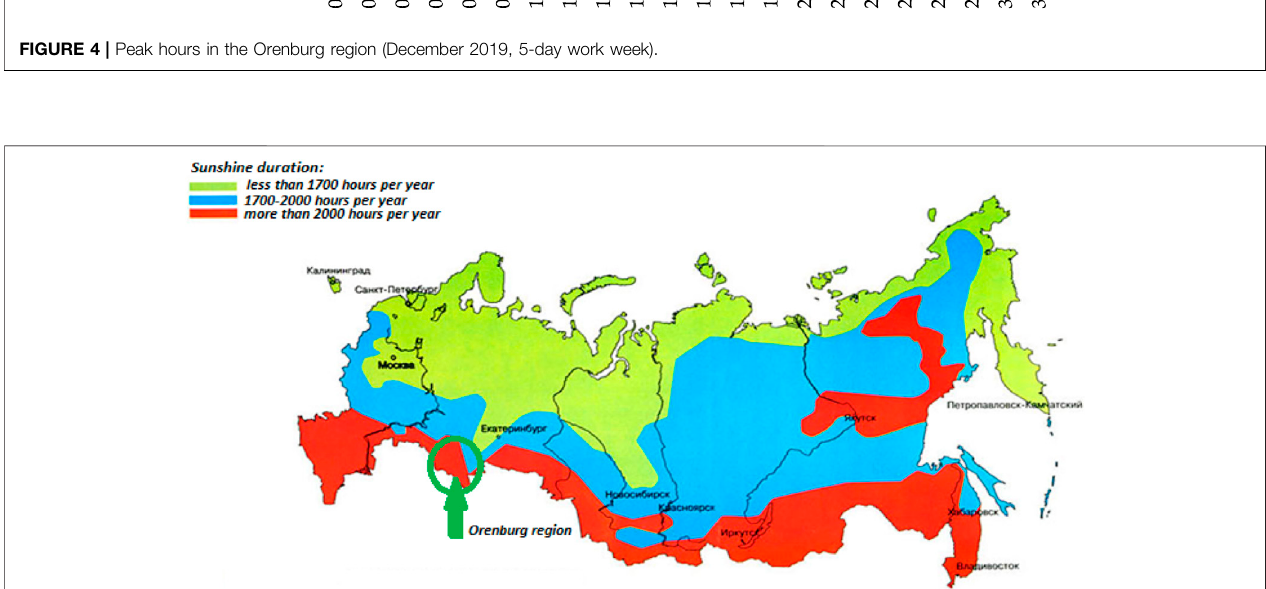
FIGURE 5 | Insolation map of Russia (Map of Insolation of Russia,